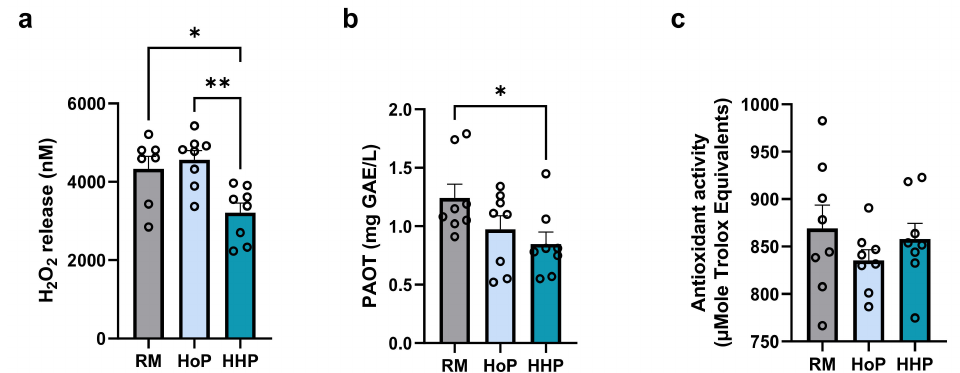
Figure 1. Impact of treatments by HoP or HHP processing of DM on milk H 2 O 2 concentrations and total antioxidant capacities. ( a ) H 2 O 2 concentration in raw (RM), HoP- and HHP-DM. Total antioxidant activity measured by PAOT-Liquid ® Technology ( b ) and ORAC assay ( c ). n = 8 for each group, * p < 0.05, ** p <